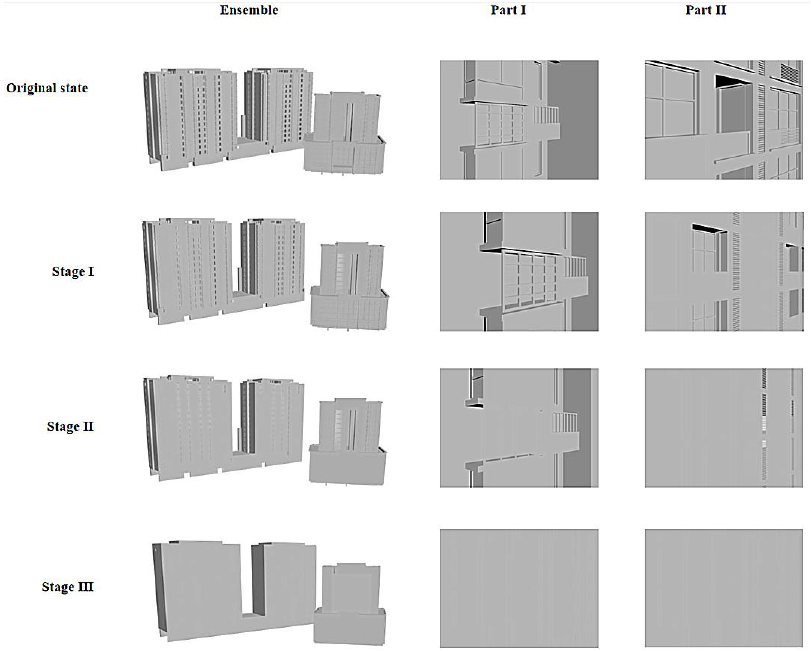
Figure 11. Continuous LOD transformation of 3D urban models (part).